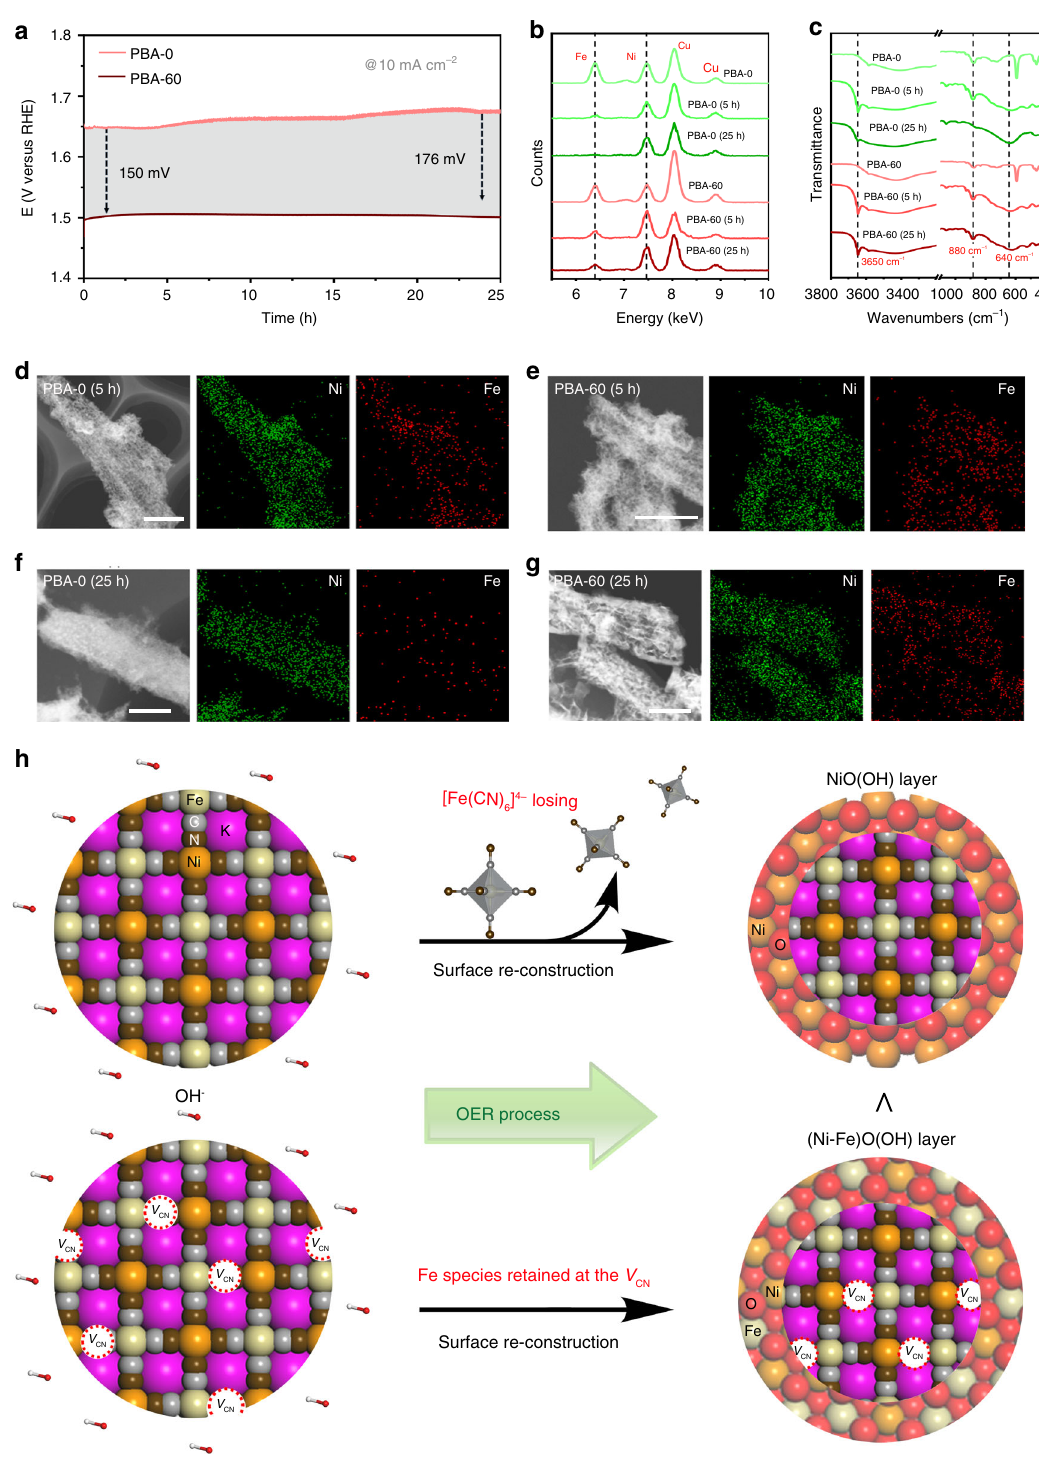
Fig. 5 Performance stability and Fe-leaching suppression. a Chronopotentiometric responses recorded on PBA-0 and PBA-60 at a constant current density of 10 mA cm − 2 . b EDX spectra of PBA-0 and PBA-60 catalysts that cycled for different times. The Cu signals come from Cu-based TEM grid. c FT-IR spectra of PBA-0 and PBA-60 catalysts that cycled for different times. d , e EDX elemental mappings of PBA-0 and PBA-60 catalysts that cycled for 5 h, respectively. Scale bars, 250 nm. f , g EDX elemental mappings of PBA-0 and PBA-60 catalysts that cycled for 25 h, respectively. Scale bars, 100 nm. h Illustrations of the surface reconstruction on the Ni – Fe PBA catalyst during OER, where the V CN enables the suppression of Fe loss, permitting the formation NiFeOOH surface active